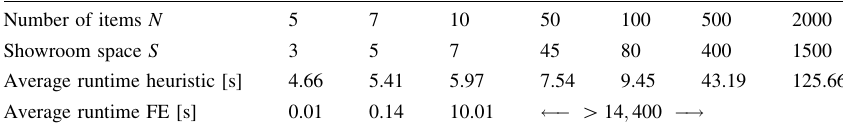
Fig. 8 Solution quality of heuristic in comparison to FE Table 7 Runtime performance of